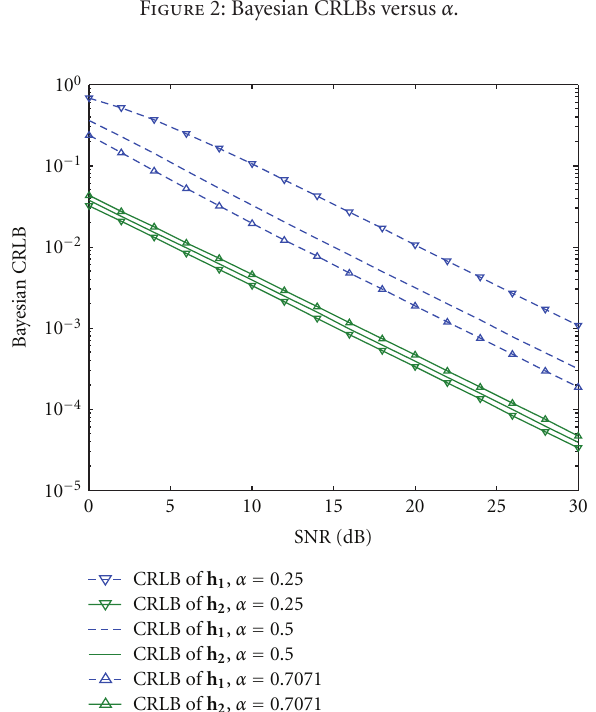
Figure 2: Bayesian CRLBs versus α .